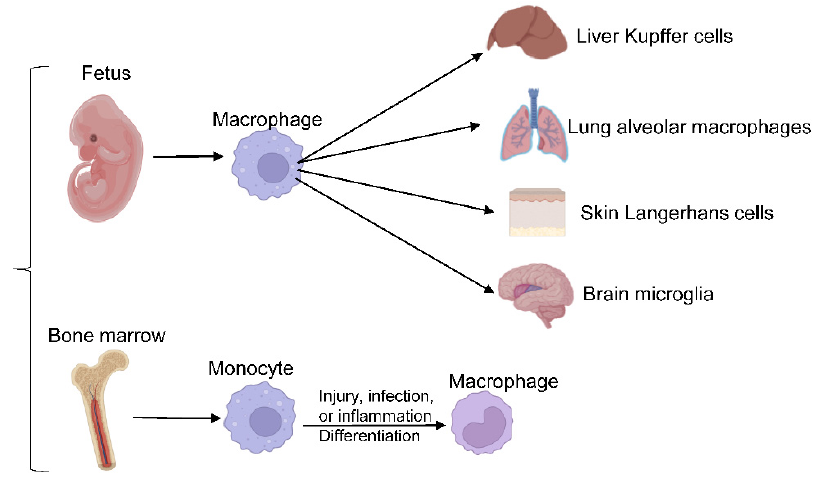
Figure 1. Macrophages differentiation. Embryo-derived macrophages differentiate into different tis- sue-resident macrophages, responding to acute or chronic demands from tissues in adulthood.